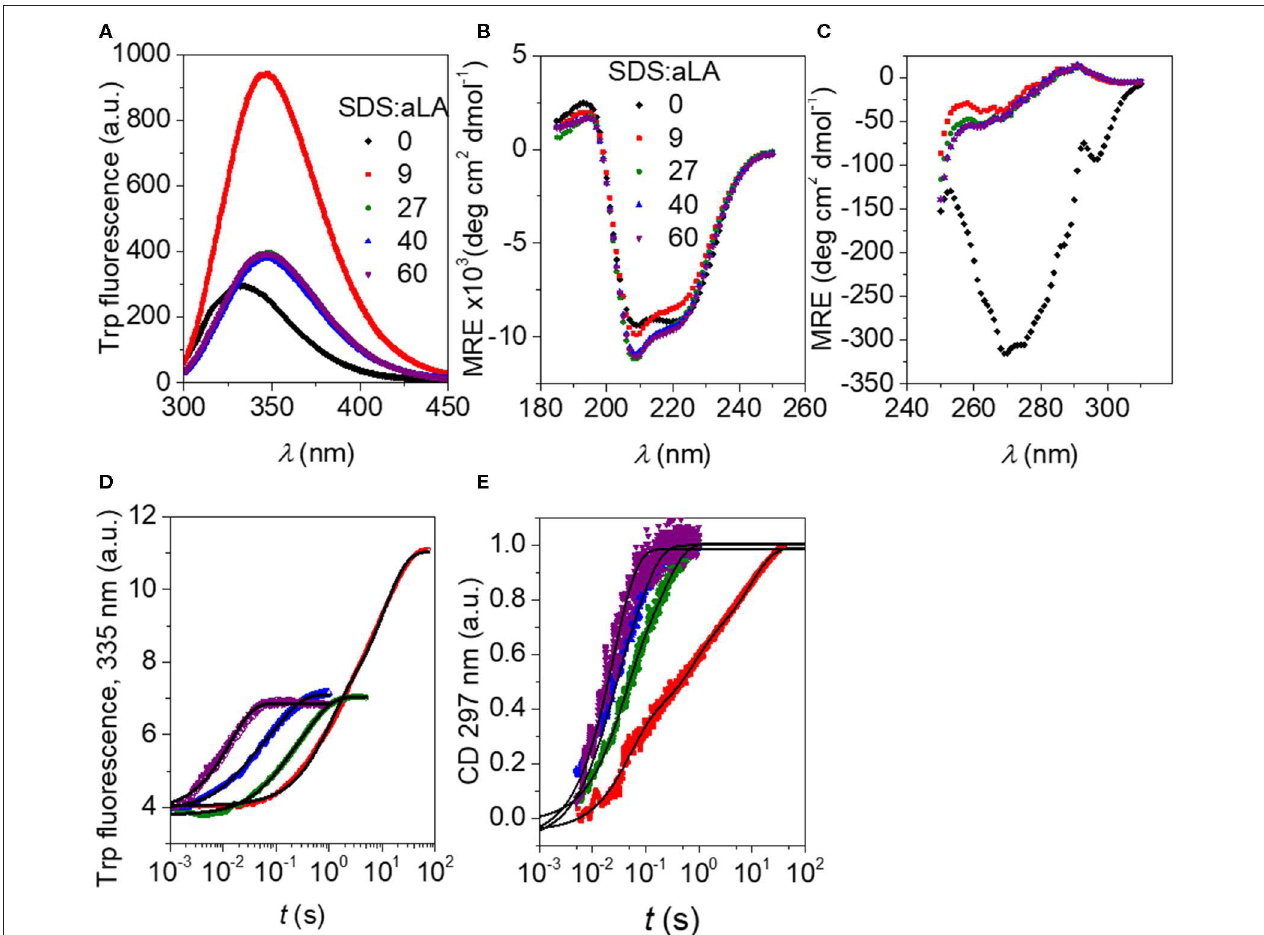
FIGURE 2 | (A) Trp fluorescence vs. wavelength for SDS:aLA mixing ratios of 0, 9, 27, 40, and 60 (black, red, green, blue, and purple points). (B) Far-UV CD spectra for SDS:aLA mixing ratios of 0, 9, 27, 40, and 60 after equilibration. (C) Near-UV CD spectra for SDS:aLA mixing ratios of 0, 9, 27, 40, and 60 after equilibration. (D,E) Trp (D) and near-UV CD (E) time profiles for 1:1 stopped-flow mixing of aLA and SDS at 9–60 SDS:aLA mixing ratios. The lines are fits to double exponential functions as described in the text.